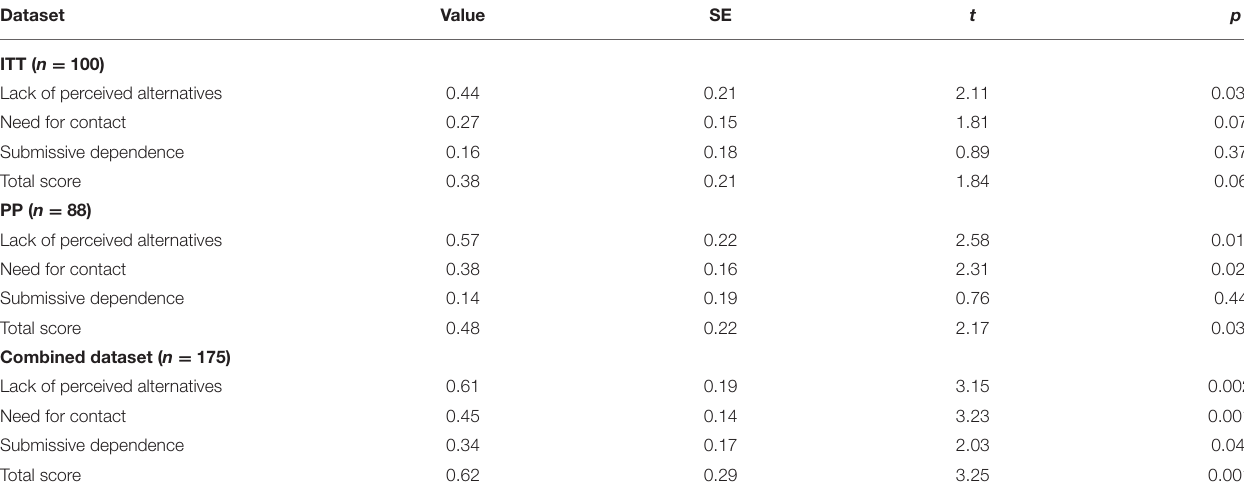
TABLE 2 | Results of multilevel-model main